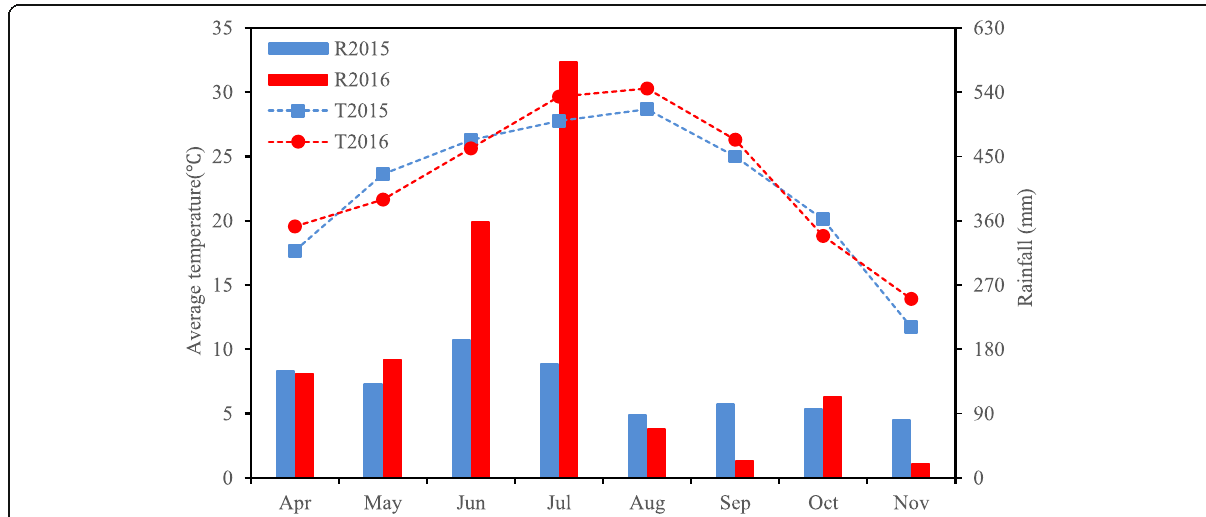
Fig. 1 Monthly weather summary during the cotton growing season in 2015 and 2016. T and R represented temperature and rainfall,